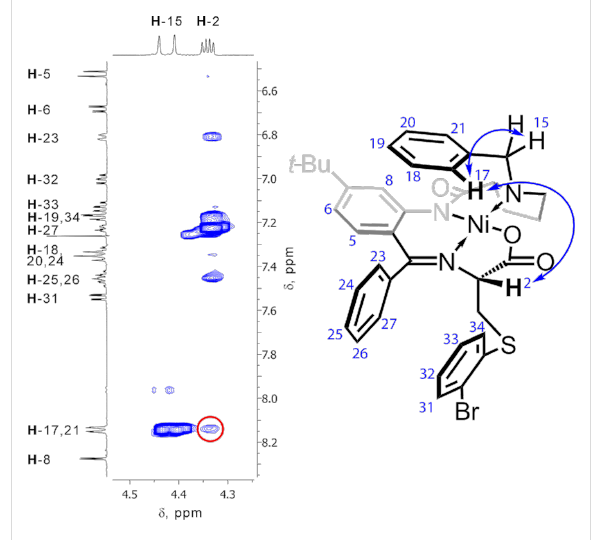
Figure 1: Fragment of the NOESY spectrum of the ʟ -( oBr CysNi ) L7 complex indicating the correlation between the H-2 and H-17,21